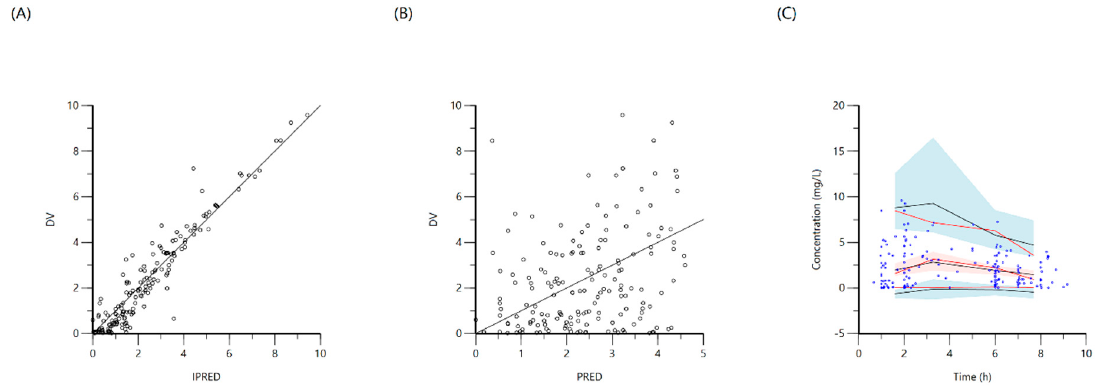
Figure 1. Goodness-of-fit plots for final population models of rifampin. Plot ( A ) represents individual predicted concen- trations (IPRED) versus observed concentrations (DV) whereas, plot ( B ) represents population-predicted concentrations (PRED) versus observed concentrations (DV). Plot ( C ), Visual predictive check (VPC) for concentrations of rifampin versus time based on 1000 Monte Carlo simulations. Blue circles represent observed rifampin concentrations, solid red lines represent the 5th, 50th and 95th percentiles of the observed concentrations, solid black lines represent the 5th, 50th and 95th percentiles of the simulated concentrations, and the shaded area represents the 90% CI of the 5th, 50th and 95th percentiles of the simulated concentrations.